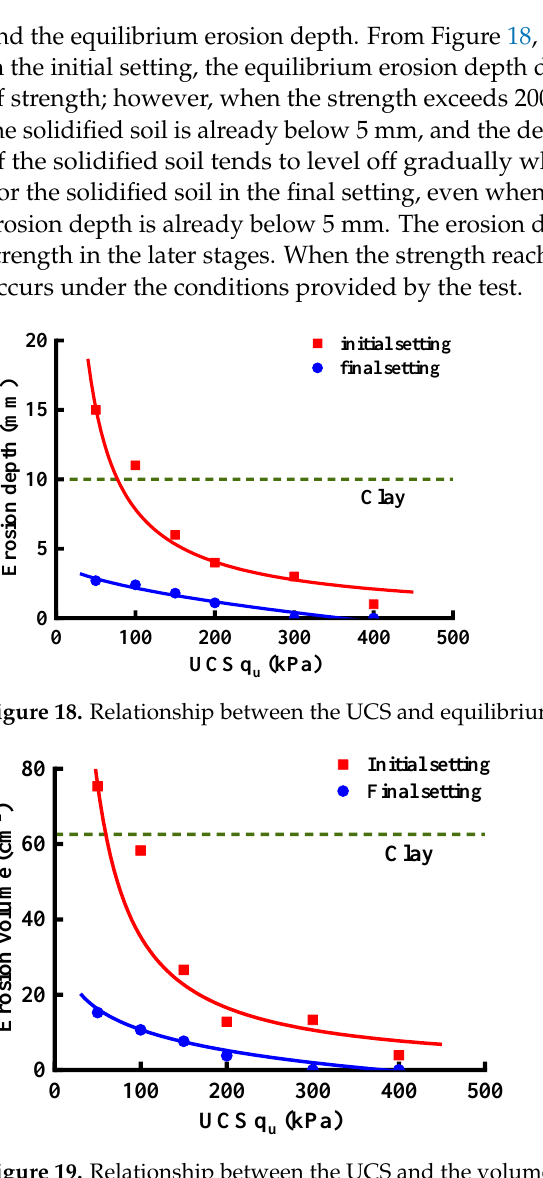
Figure 19. Relationship between the UCS and the volume of erosion.